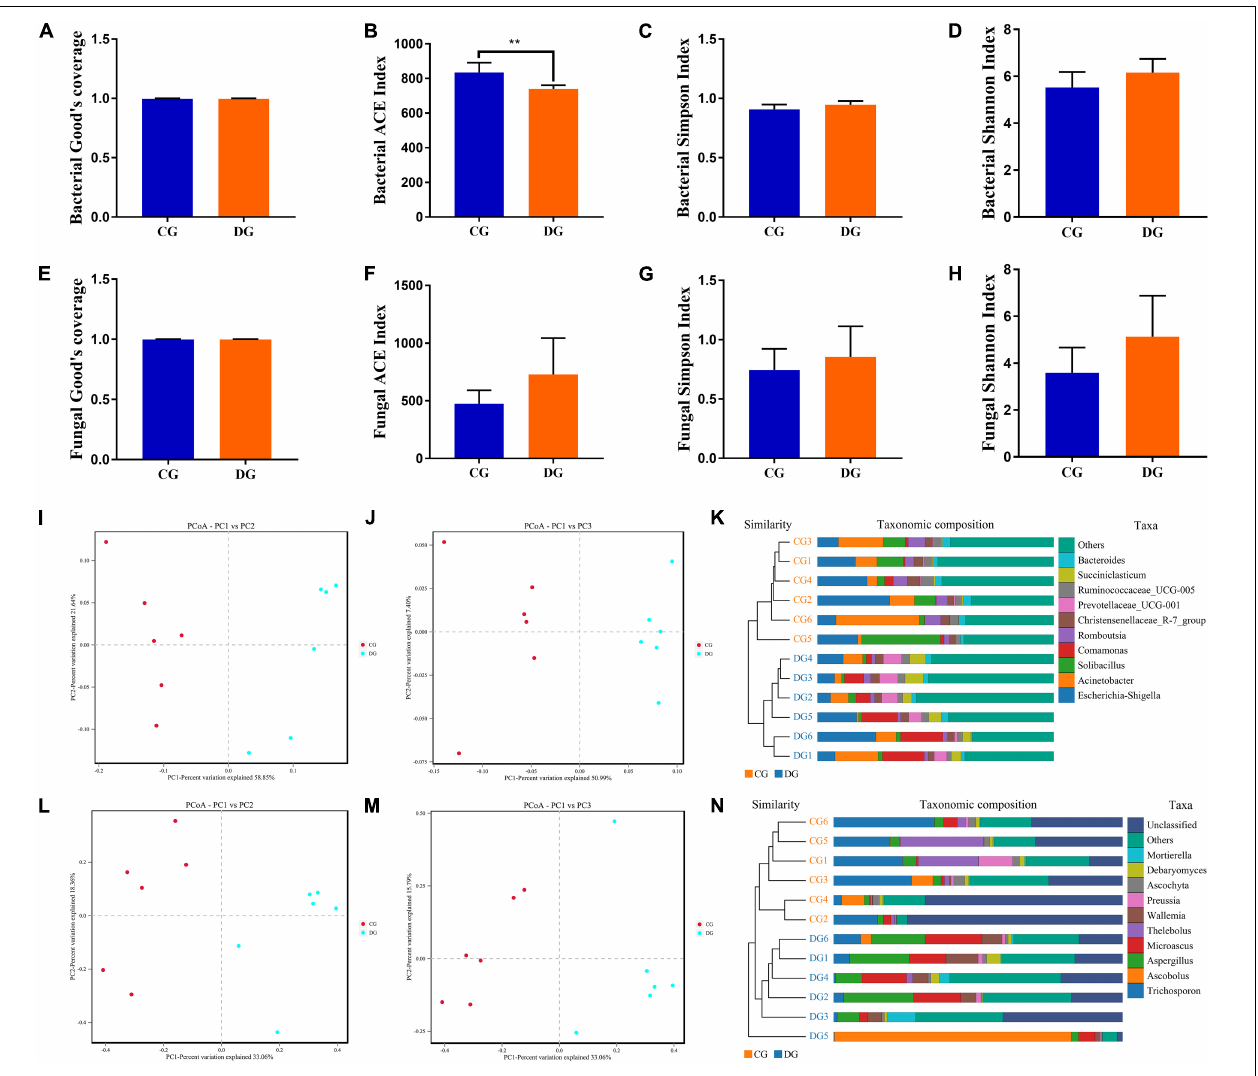
FIGURE 2 | The alternations of gut bacterial and fungal diversities during diarrhea. Gut bacterial and fungal alpha diversities can be evaluated by Good’s coverage (A,E) , ACE (B,F) , Simpson (C,G) , and Shannon (D,H) . (I,J) Principal coordinate (PCoA) analysis based on the weighted and unweighted UniFrac distance of gut bacterial community. (L,M) Principal coordinate (PCoA) analysis of gut fungal community. (K,N) Gut bacterial and fungal clustering analysis based on unweighted pair-group method with arithmetic means (UPGMA). All of the data represent means ± SD. ** p <